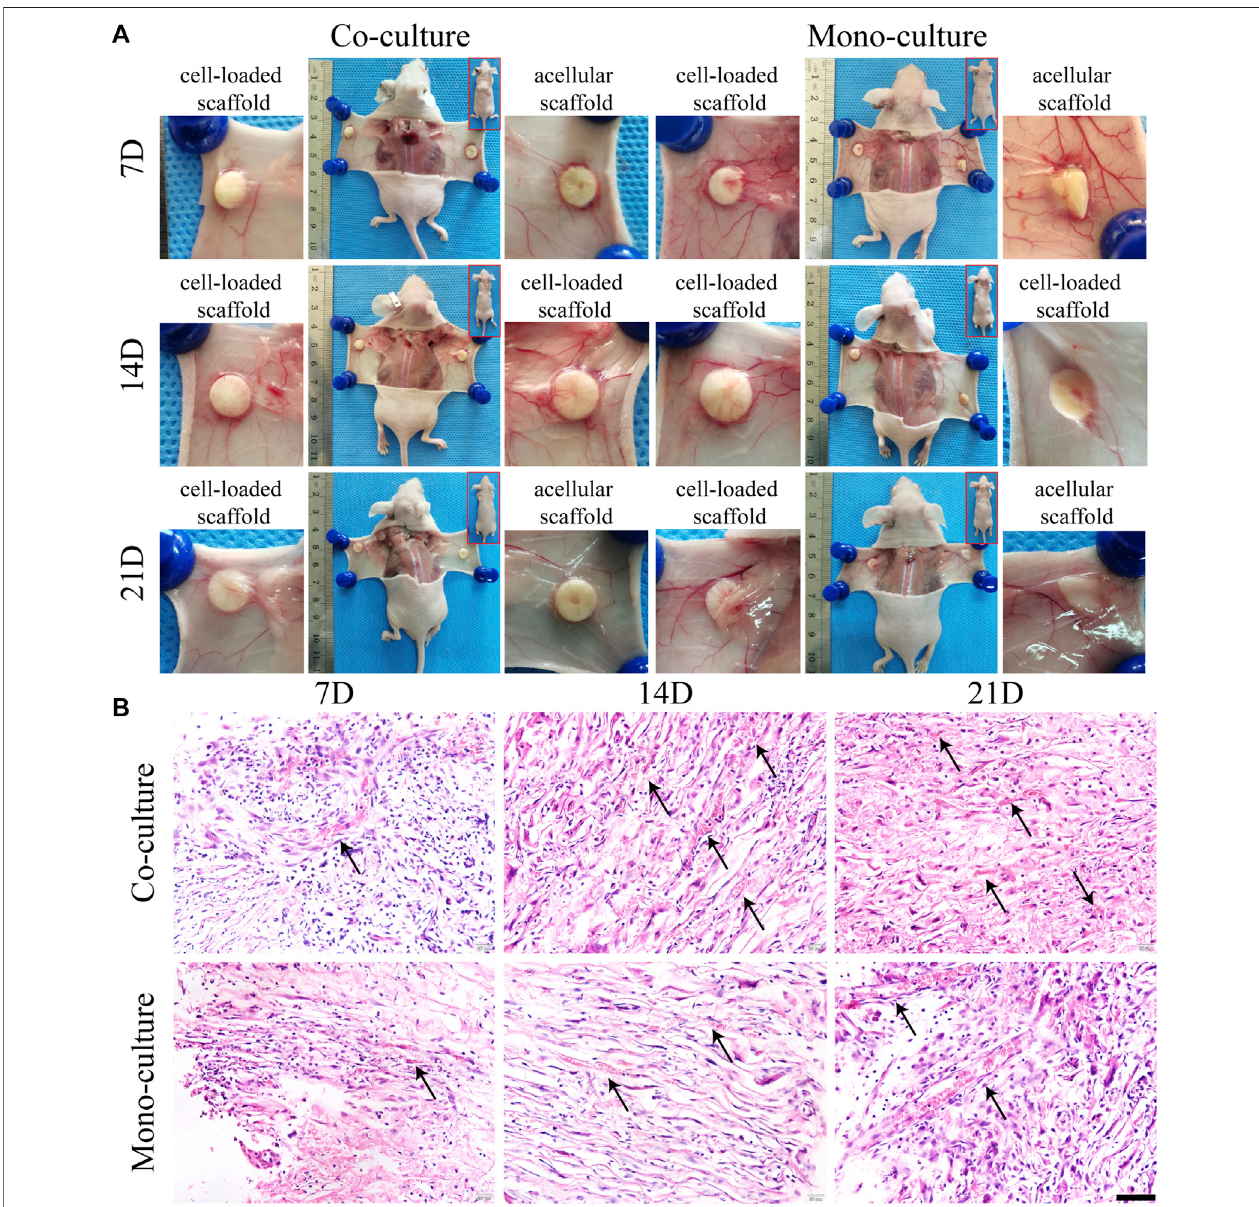
FIGURE9| Morphologicalcharacterizationofcell-loadedculturesaftertransplantation.Generalgrowthmorphologyofscaffoldsineachgroupwasshownat7,14, and 21 days after transplantation (A) . H&E staining (B) showed radially distributed cells in the scaffolds. Host blood vessels (black arrows) grew abundantly within the pores of all cultures, especially the co-cultures. Scale bar, 50